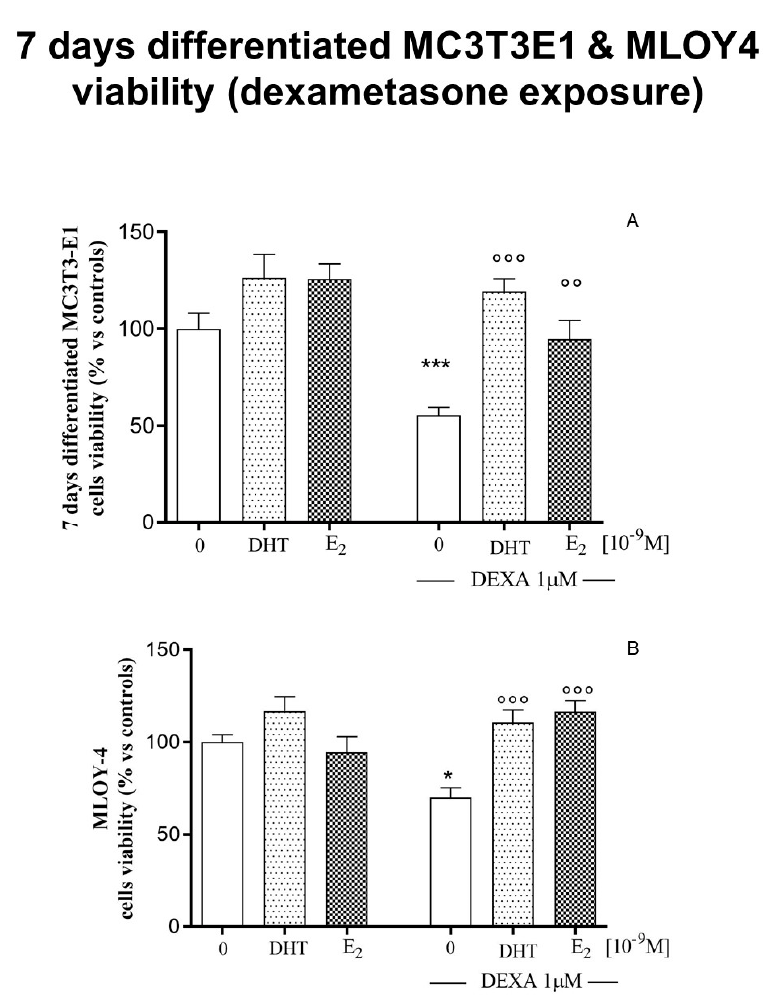
Figure 4. Effects of steroids on counteracting dexametasone-induced oxidative stress in osteocyte-like cells, MLOY-4 and in differentiated osteoblasts, MC3T3. Effects of 10 − 9 M steroids on dexametasone-induced cytotoxicity in osteocyte like cells, MLOY-4, and differentiated osteoblasts, MC3T3-E1. Cells were pre-treated with E2 or DHT, 24 h before being treated with dexametasone (1 µ M for 48 h). We measured cell viability by MTT assay 2 h after treatment. ( A ): effects of steroids on dexamethasone-induced cytotoxicity in differentiated MC3TE1 cells; ( B ) shows the effects of steroids on dexamethasone-induced cytotoxicity in MLOY-4 cells. 0 column indicates the group without and with dexamethasone. Data are represented as the mean ± SEM of six replicates within a single experiment. The experiment was repeated three times. Differences between groups were evaluated by one-way ANOVA, followed by Bonferroni post-hoc test *** p < 0.001; * p < 0.05 vs. control without dexamethasone; ◦◦◦ p < 0.01; ◦◦ p < 0.01 vs. control with